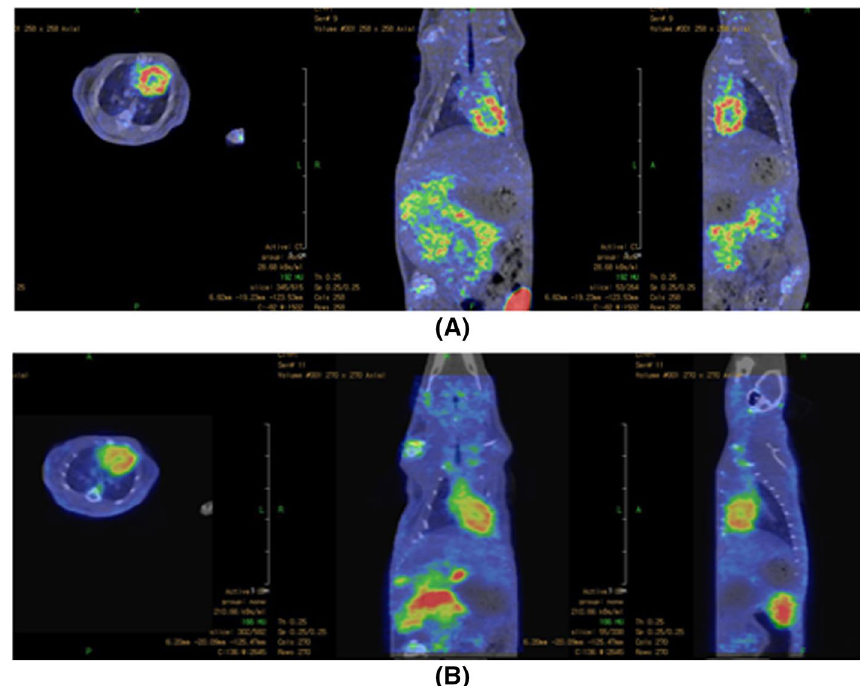
Fig. 3 Coronal, transaxial, and sagittal images of normal rats after 60 min post-injection using ( A ) 64 Cu-NOTA-rhodamine and ( B ) 64 Cu-NOTAM-rhodamine conjugates (injected dose 7.4 MBq